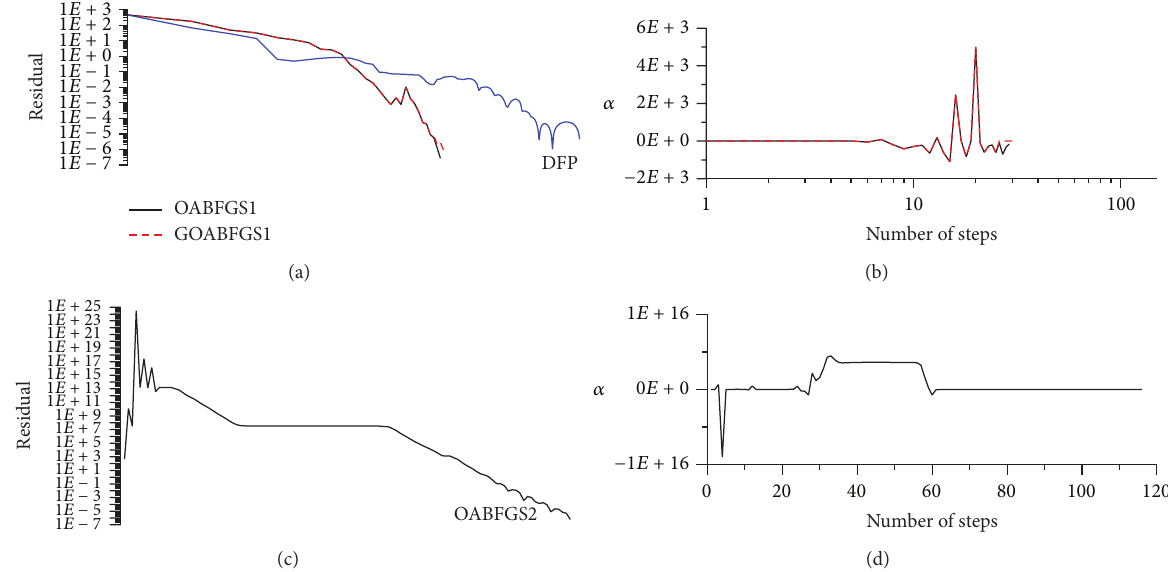
Figure 6: For the Powell problem, comparing (a) the residuals and (b) 𝛼 obtained by the OABFGS1 and GOABFGS1 with DFP and showing (c) the residual and (d) 𝛼 obtained by OABFGS2.